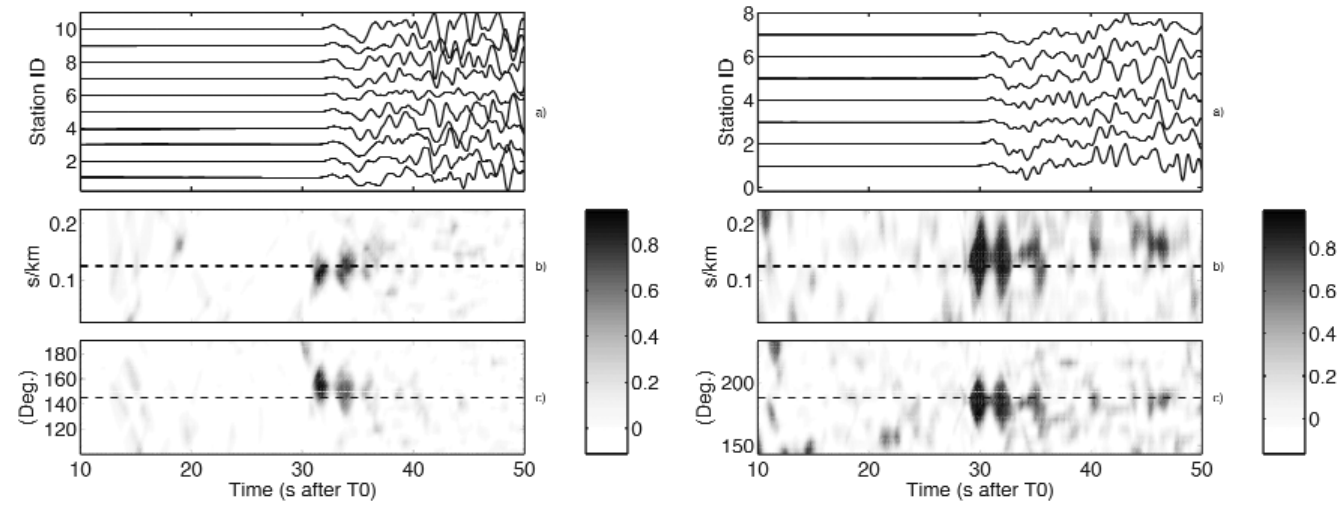
Figure 2 (left). (a) Vertical-component velocity seismograms from array AVT. Traces are aligned to the P-wave arrival times, and adjusted using cross-cor- relation. (b) ZLCC as a function of horizontal slowness, for a constant propagation azimuth equal to that measured for the first pulse (151.7˚; see Table 1). (c) ZLCC as a function of propagation azimuth, for a constant horizontal slowness of 0.12 s/km as measured from the first P-wave arrival (see Table 1). Dashed lines in (b) and (c), theoretical horizontal slowness and propagation azimuth expected for the one-dimensional velocity structure of Li et al. [2007]. Figure 3 (right). As for Figure 2, from the LRD array. See Table 1 for the theoretical and measured propagation